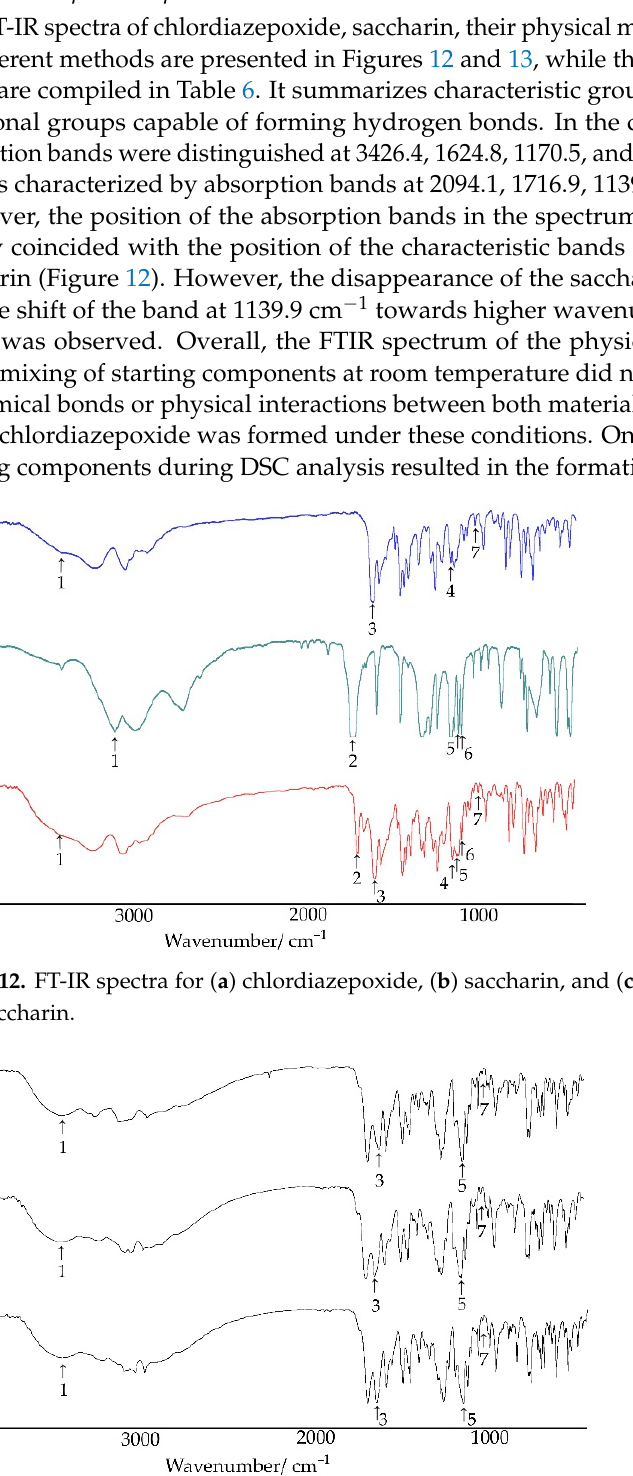
Figure 13. FT-IR spectra for saccharin salts of chlordiazepoxide prepared using the following methods: ( a ) liquid-assisted grinding, ( b ) crystallization from ACN, and ( c ) crystallization from MeOH/ClMe.